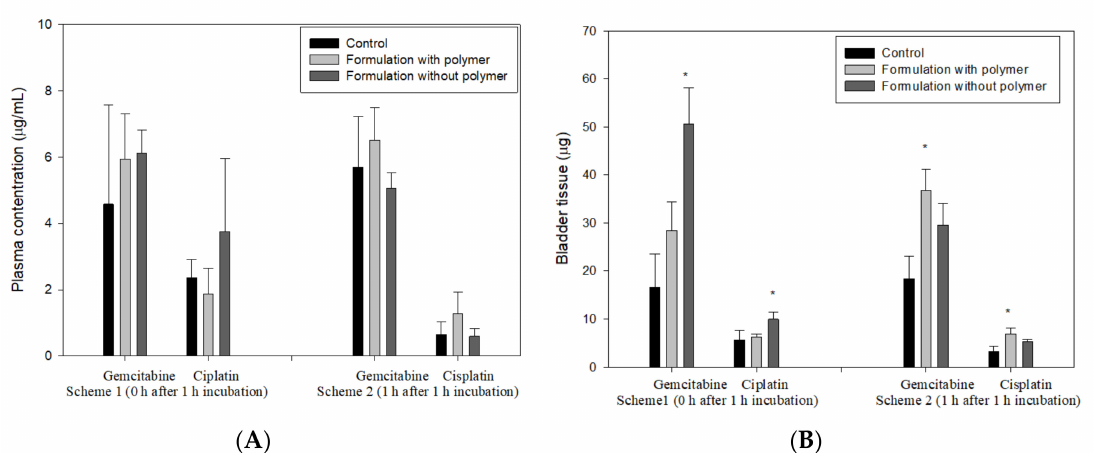
Figure 3. The plasma concentration ( A ) and deposition amount ( B ) of gemcitabine and cisplatin in the bladder of dual-loaded microemulsions of F3 and control solution after intravesical administration (scheme 1: 0 h after 1 h incubation; scheme 2: 1 h after 1 h incubation) (* p <